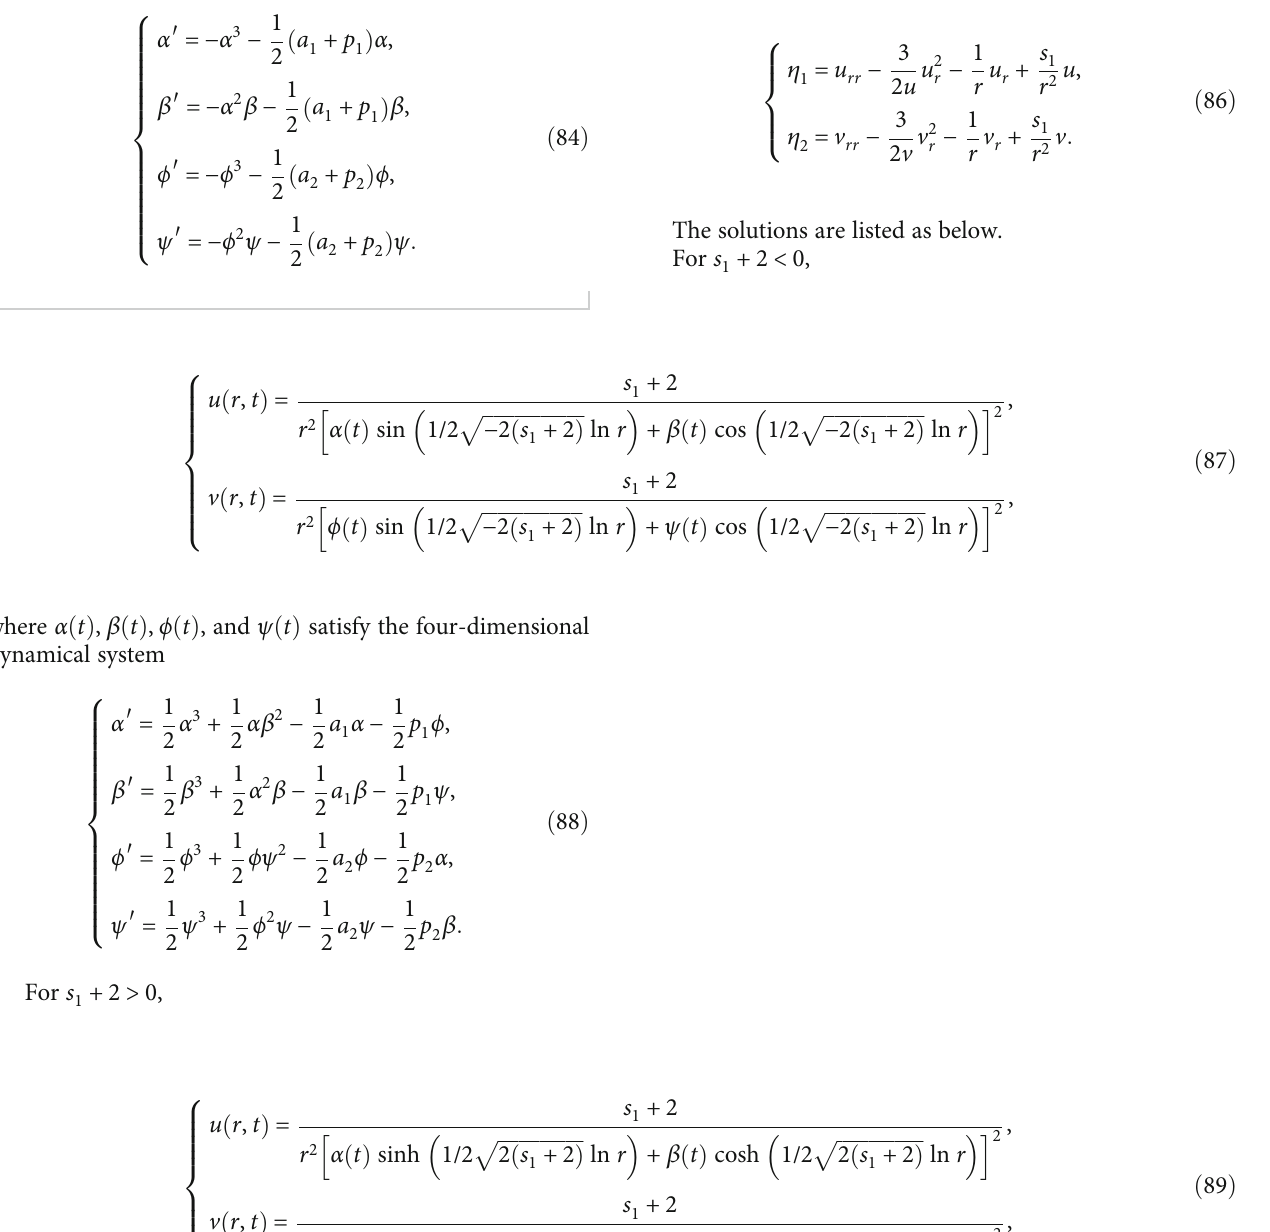
ffiffiffiffiffiffiffiffiffiffiffiffiffiffiffiffiffi 2 s